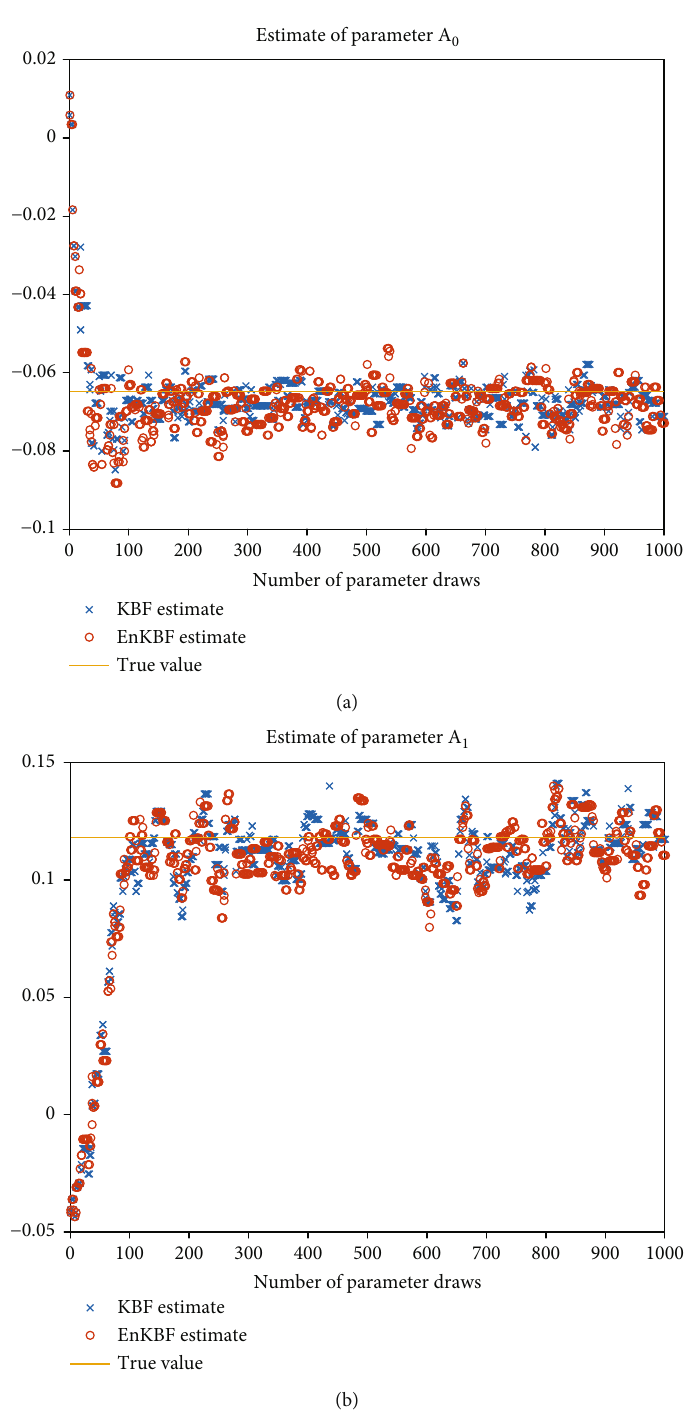
Figure 5: Plots for velocity parameters for the fi rst three parameters in λ obtained using KBF and EnKBF and run for 1000 time steps and 1000 Metropolis-Hastings cycles. The number of particles used for EnKBF is M = 1000 , the time step size used in both fi lters is dt = 0 : 01 , μ = 0 : 001 , and 100 grid points are used. The plots indicate that the estimates, for both fi lters, converge after about 100